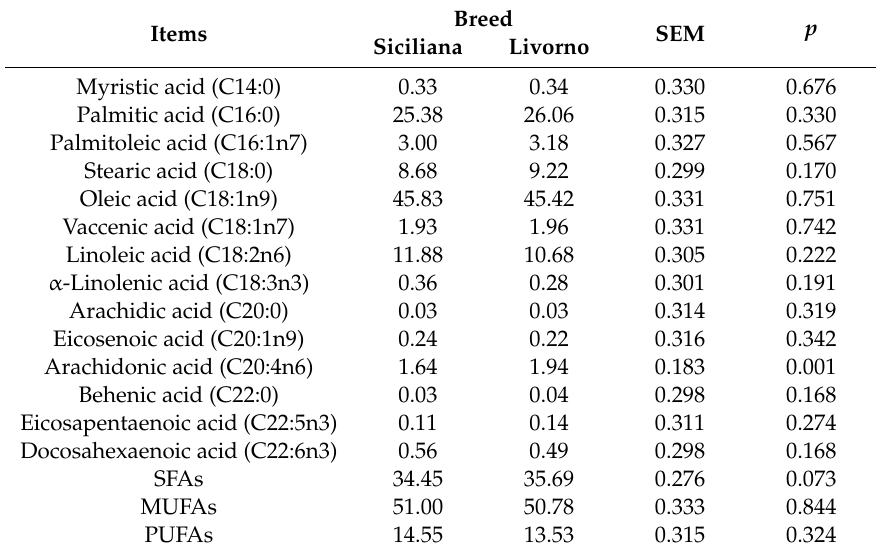
Table 4. Fatty acid composition of eggs yolk (g · 100 g − 1 FAME)